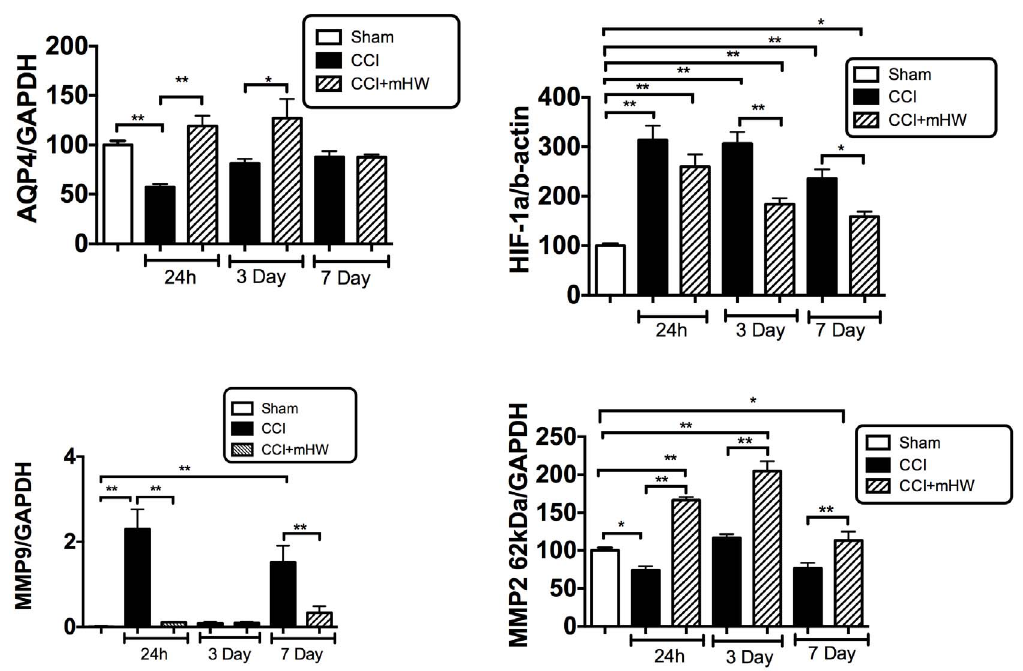
Figure 8. Effects of CCI and mHW on AQP-4, HIF-1, and MMP-2 & -9 Levels. The upper left panel shows that CCI suppressed AQP-4 expression at 24 h and that mHW blocked this decrease. HIF-1 (upper right panel) was increased at all times after CCI and mHW induced a partial recovery. MMP-9 (lower left panel) showed elevations 24 h and 7 days after CCI that were blocked by mHW. MMP-2 was decreased 24 h after CCI but mHW increased levels at all time points.